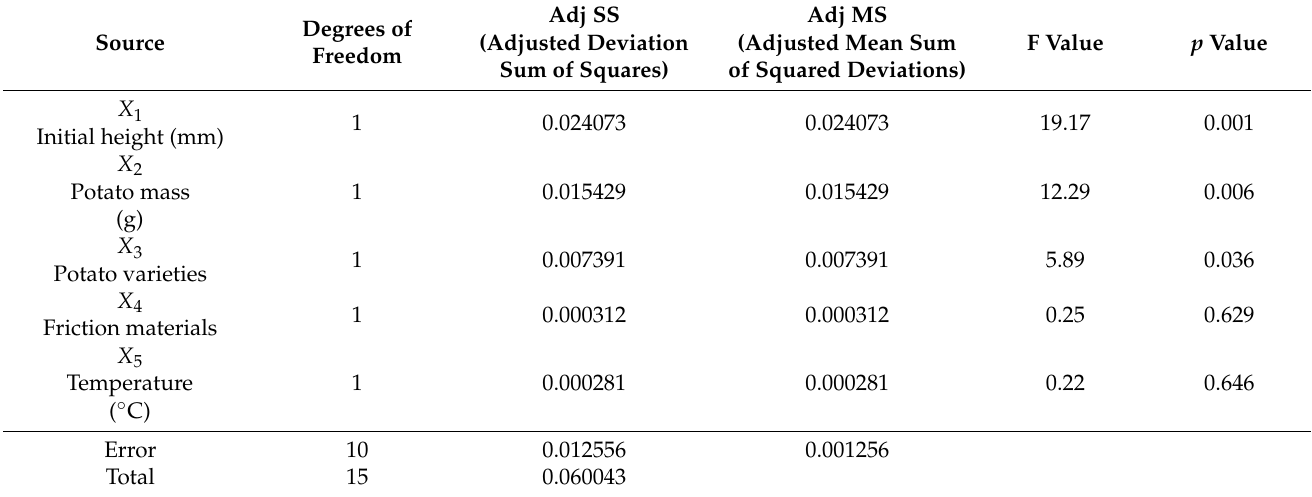
Table 3. Variance analysis of factorial test